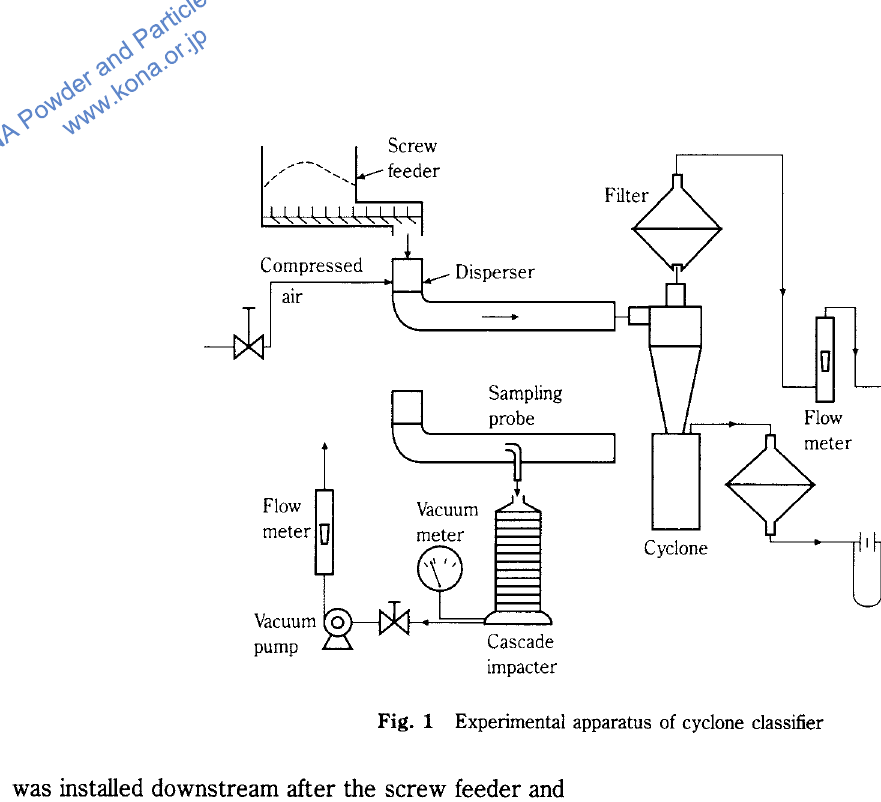
Fig. 1 Experimental apparatus of cyclone classifier